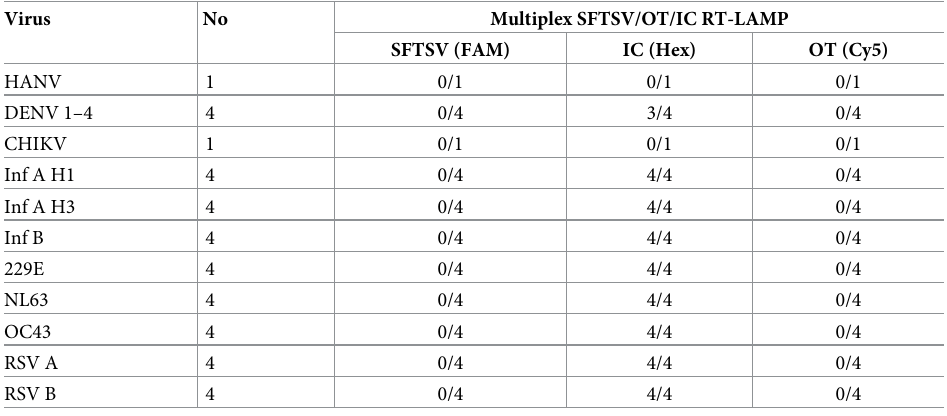
Table 5. Cross-reactivity of the multiplex SFTSV/ OT /IC RT-LAMP assay against other fever infectious